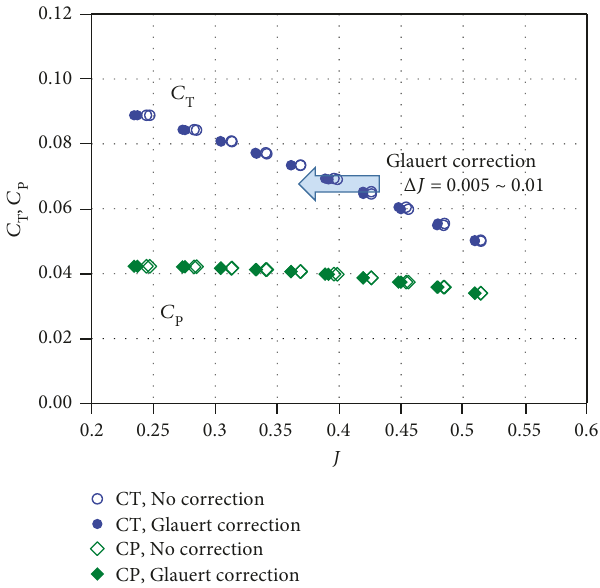
Figure 17: Change of performance coe ffi cient due to Glauert